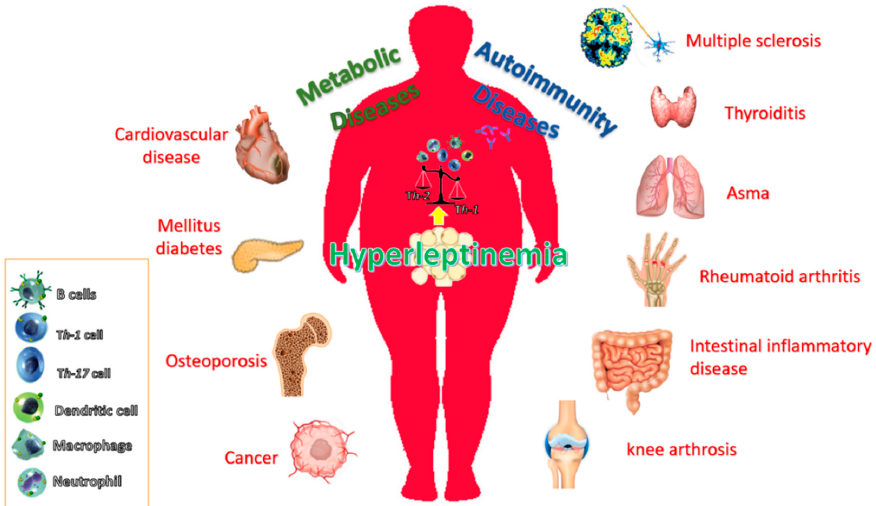
Figure 1. Leptin action contributes to chronic inflammation in obesity. Obesity is associated with increased leptin levels, which at the local or systemic level activate the cells of the innate and adaptive immune system. In this context, leptin can directly promote environmental conditions that in turn promote the loss of immune self-tolerance and priming immune cells for Th1 phenotype (proinflammatory). The elevated circulating leptin levels in obesity contribute to the low-grade inflammatory background, which makes obese individuals more susceptible to an increased risk of developing metabolic diseases such as cardiovascular diseases, T2D, as well as, degenerative disease including autoimmunity diseases (multiple sclerosis, thyroiditis, rheumatoid arthritis, intestinal inflammatory disease and knee arthrosis among others) and cancer.